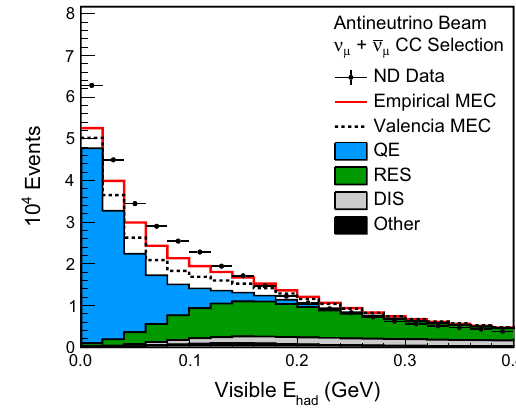
Fig. 3 Comparison of ND data to simulation in reconstructed visible hadronic energy using the default GENIE empirical MEC model (solid red curve) or the València MEC model (dotted black curve), in neutrino